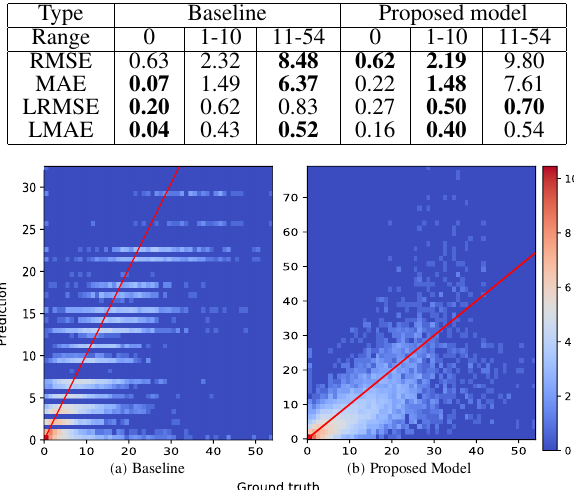
Table 3. Per-range counting results on the test set of the high resolution dataset. Bold indicate the best result for each metric and each range.